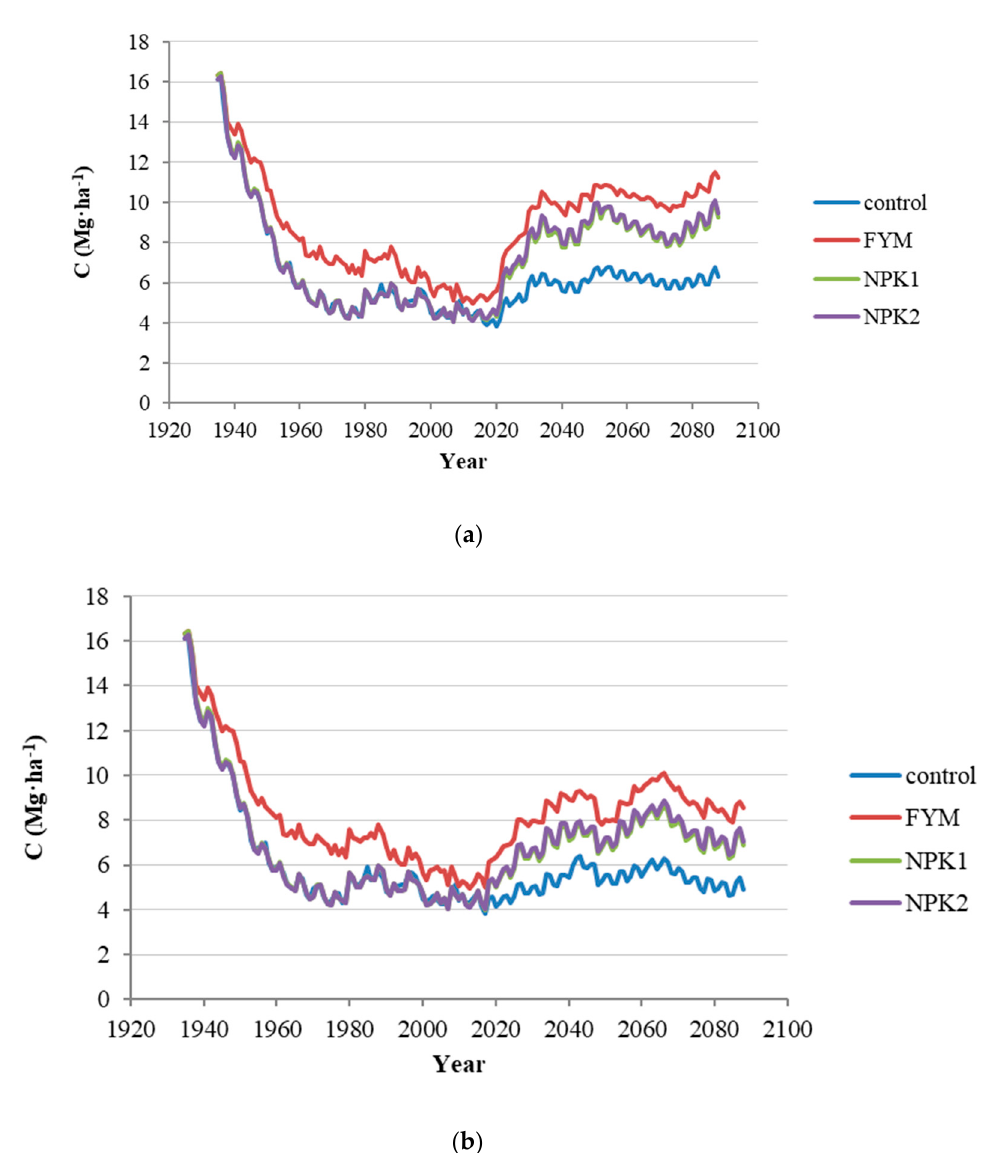
Figure 4. Simulated annual dynamics of C in the resistant plant material (RPM) pool in the DAOS 4 experiment: ( a ) RCP4.5 and ( b ) RCP8.5.